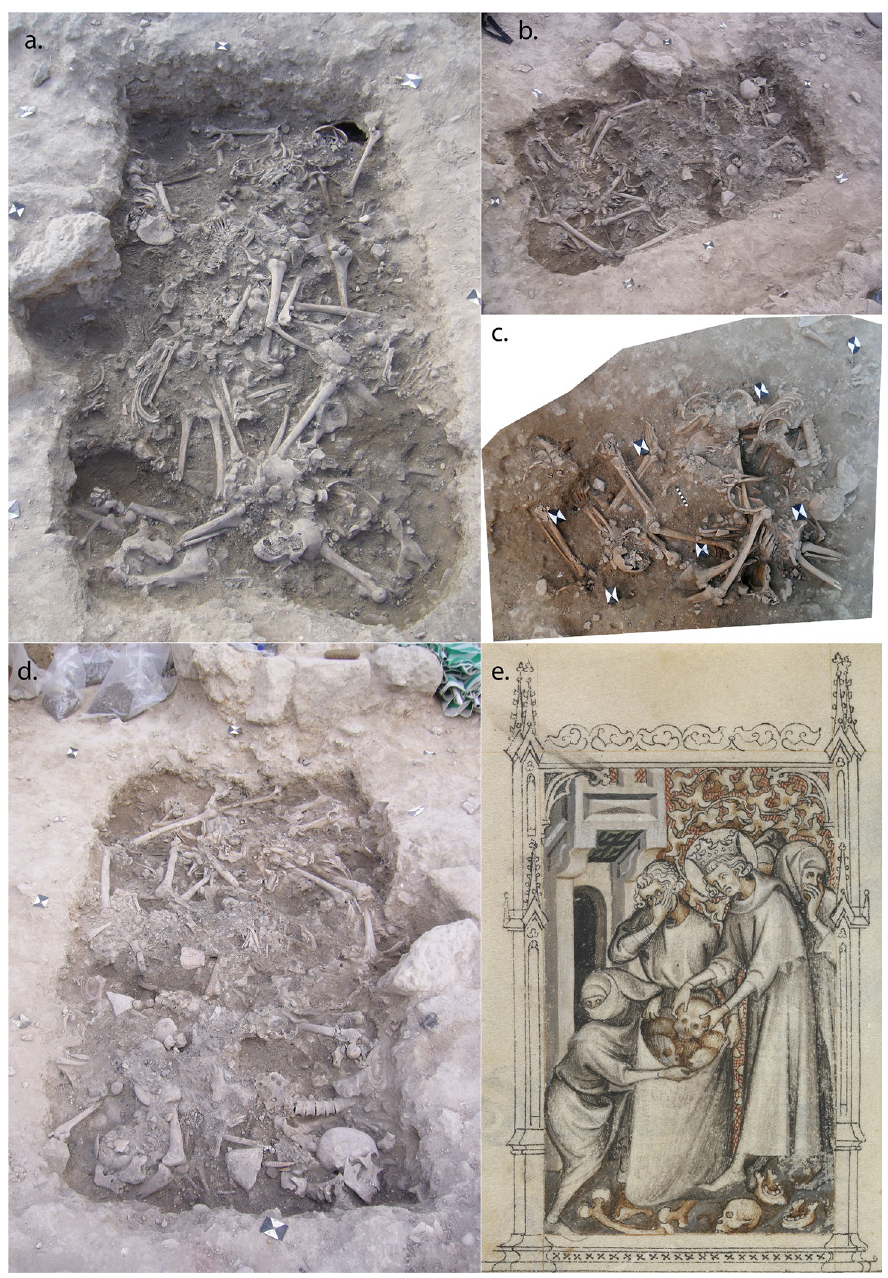
Fig 2. Images of the mass graves at Sidon: a) Burial 110, layer 8, looking east; b) Burial 110, showing how the rectangular grave has truncated one of the earlier Iron Age stone post pads; c) Rectified photograph of burial 101, demonstrating the greater degree of skeletal articulation; d) Burial 110, layer 4, looking west; e) Detail of Jean Pucelle’s The Hours of Jeanne D’Evreux , depicting King Louis IX of France helping to collect and bury the remains of those killed in the Mamluk raid on Sidon in 1253 CE (images: a), b) & d) R. Mikulski/DGA; c) courtesy of C. Doumet- Serhal/DGA; e) The Metropolitan Museum of Art, New York, The Cloisters Collection 1954, MS 54.1.2, fol. 159v, www.metmuseum.org).